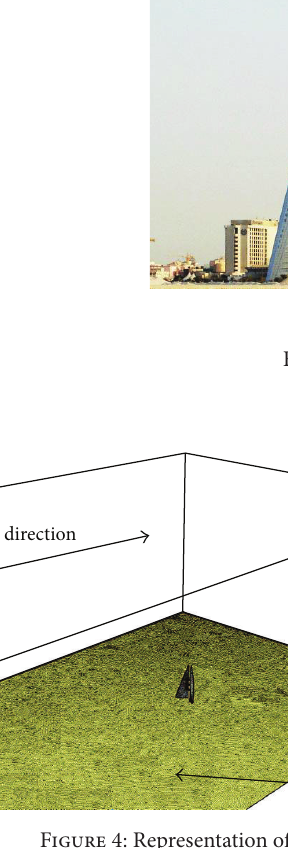
Figure 4: Representation of the flow domain.